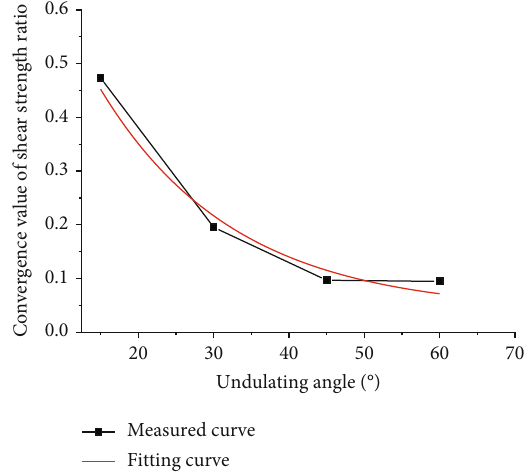
Figure 6: Curves of convergence value of shear strength ratio.